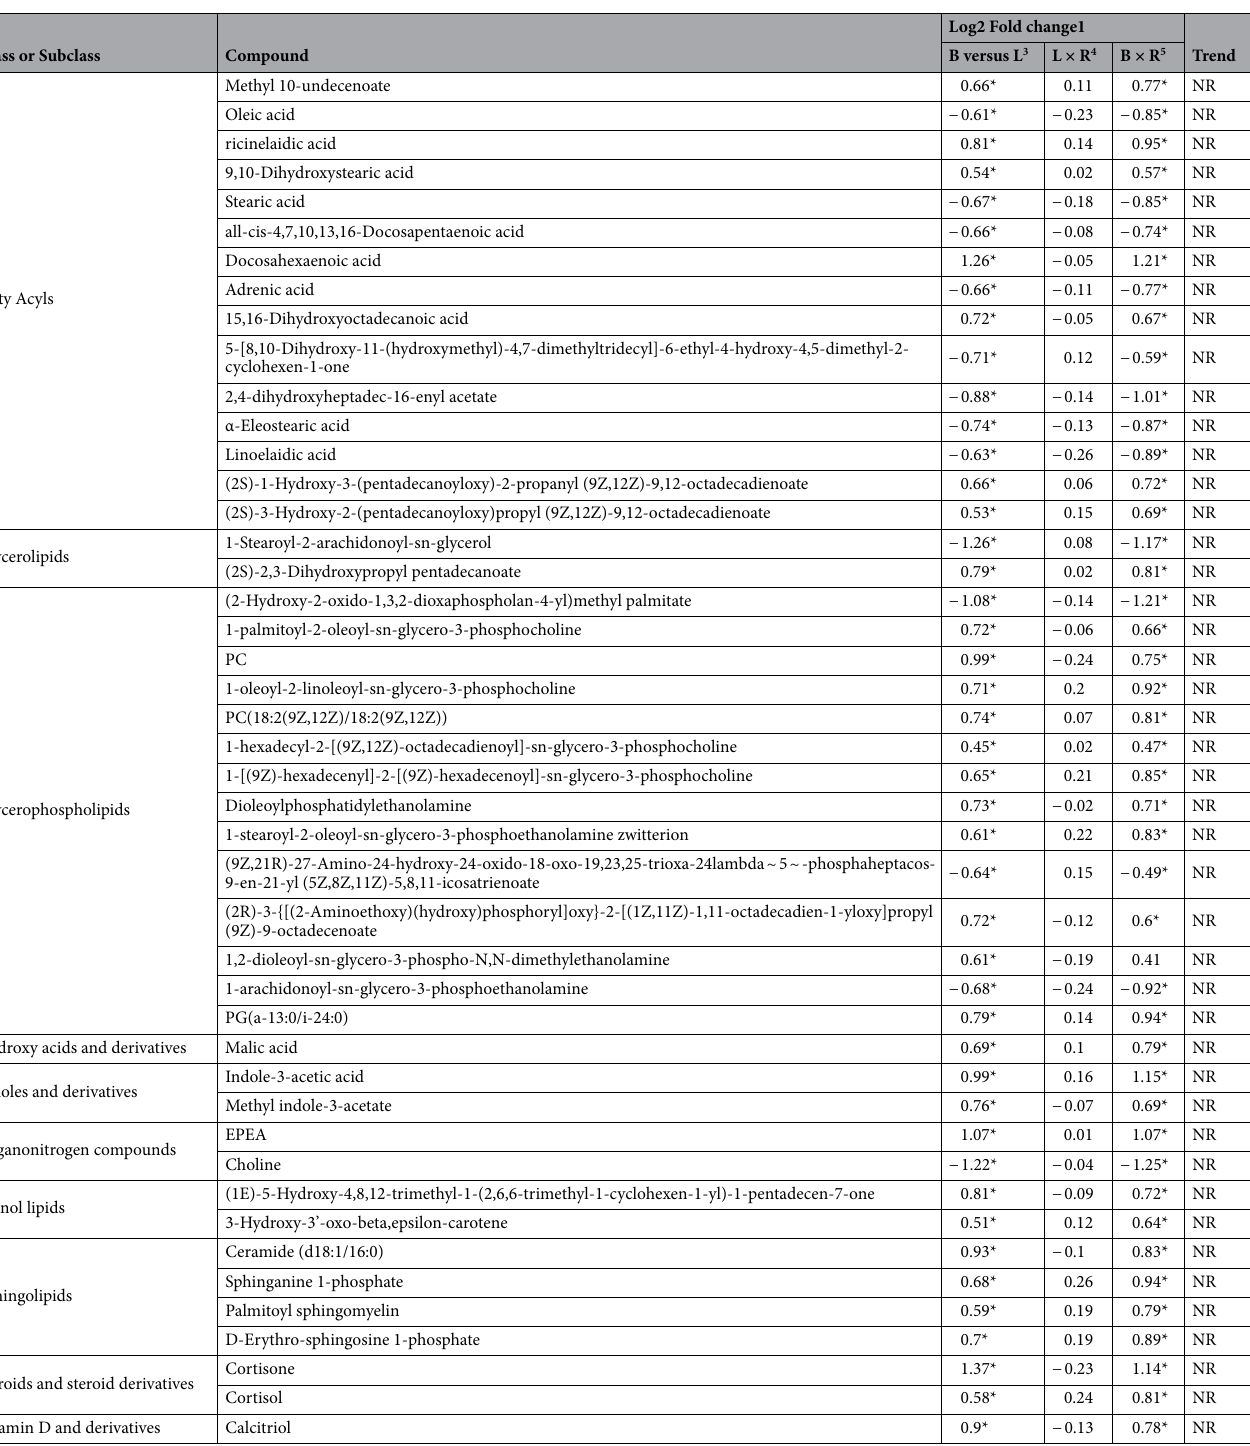
Table 3. Metabolites associated with gonadotropin level. Do not include putative metabolites present in Table 1. R = Recovery profile ( p value < 0.05, Low vs. Restored)/TR = Tendency to recovery ( p value > 0.05, Low vs. Restored))/ NR = Non-restored. 12 B versus L = Basal versus Low (Basal–Low) / 3 L versus R = Low versus Restored (Low-Retored)/ 4 B versus R = Basal versus Restored (Basal–Restored) / * p value < 0.05, Pairwise comparison (Turkey Posthoc). Log2Fold Change: negative values were linked to relatively high abundant metabolites and positive values to relatively low abundant